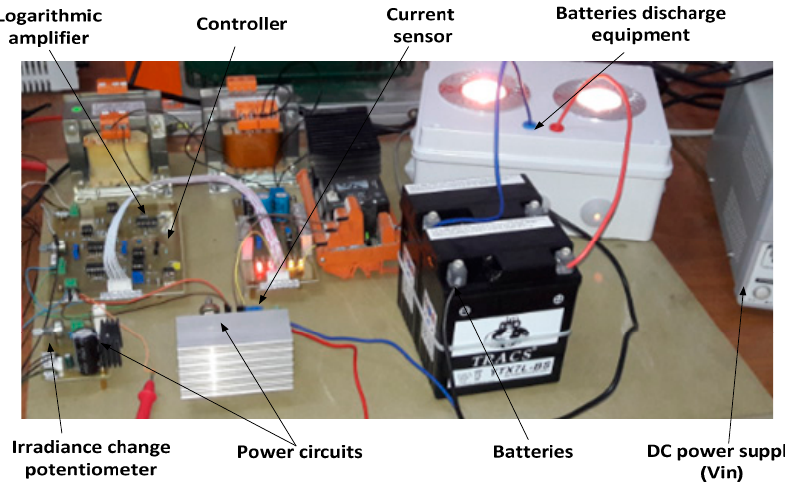
Figure 11. Photo of the experimental test